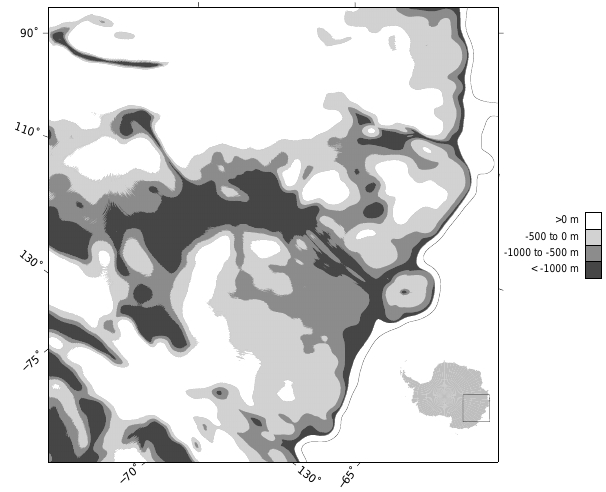
Fig. 2. Unconstrained inferred ice sheet basal elevation based on a constant κ =